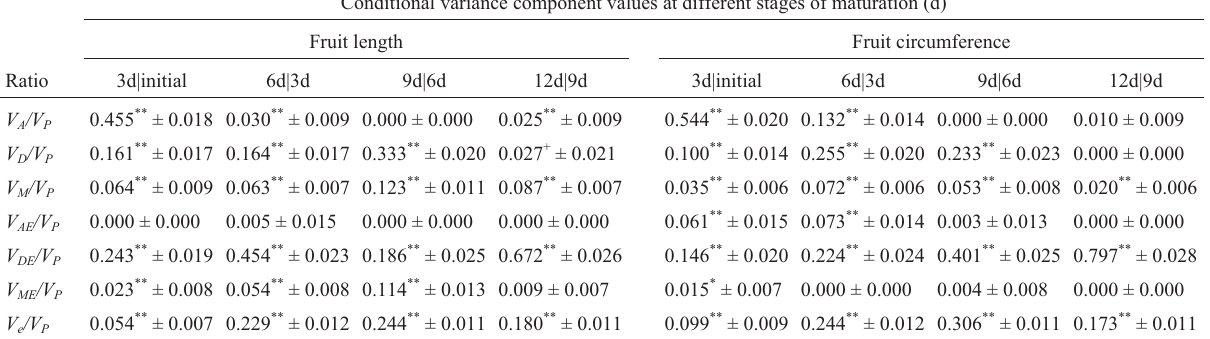
Table 3 - Estimation of conditional variance components of sponge gourd ( Luffa cylindrical (L) Roem.) fruit length and circumference at different stages of maturation. Conditional variance component values at different stages of maturation (d) Fruit